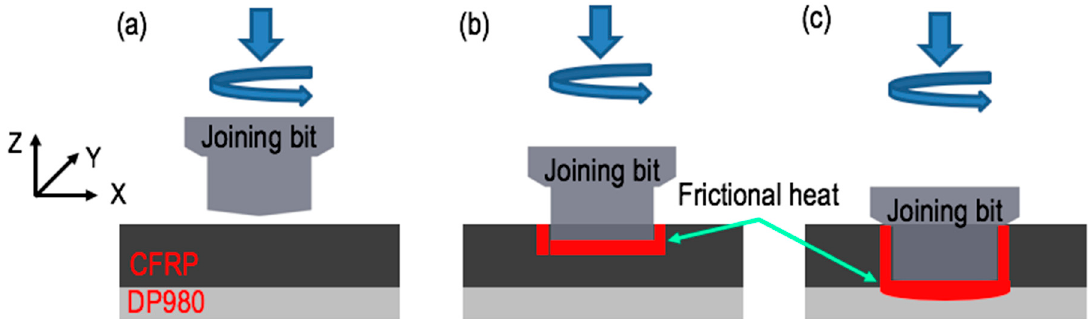
Figure 1. A schematic of the friction bit joining (FBJ) process: ( a ) initial stage, ( b ) cutting and plunge stage, and ( c ) joining stage.